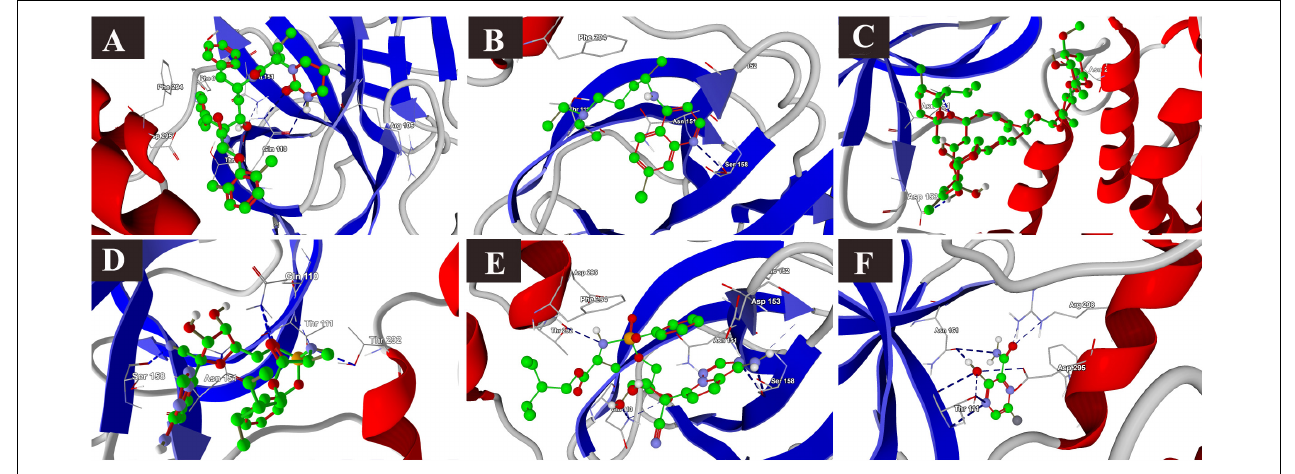
FIGURE 4 | Binding interactions of selected drugs with SARS-CoV-2 main protease. (A) lopinavir, (B) chloroquine, (C) hydroxychloroquine, (D) ivermectin, (E) remdesivir, and (F)